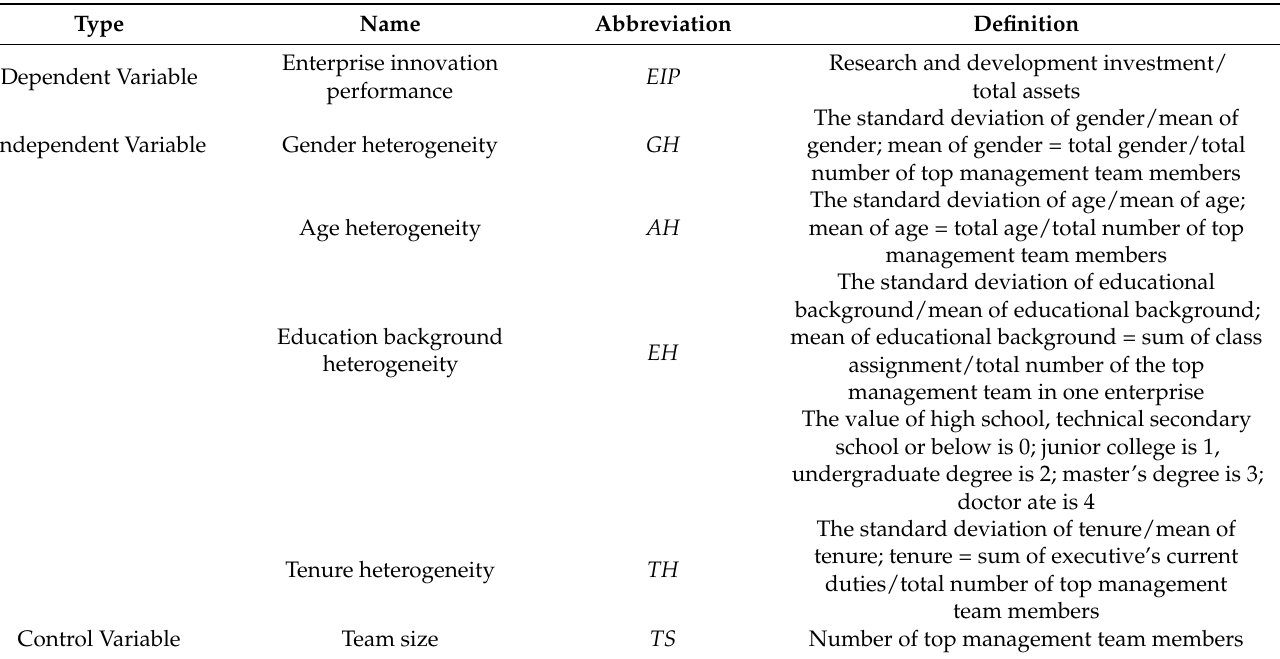
Table 1. Variable definitions and descriptions.